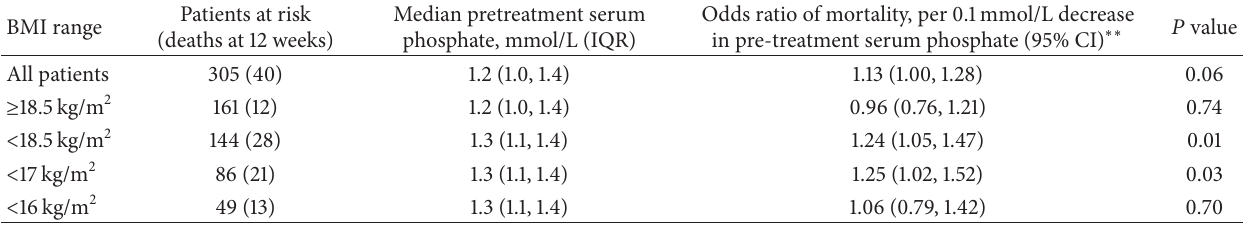
Table 2: Pre-treatment serum phosphate and odds ratios of death prior to 12 weeks among study participants, stratified by BMI ( 𝑛 = 305 ) ∗ . BMI